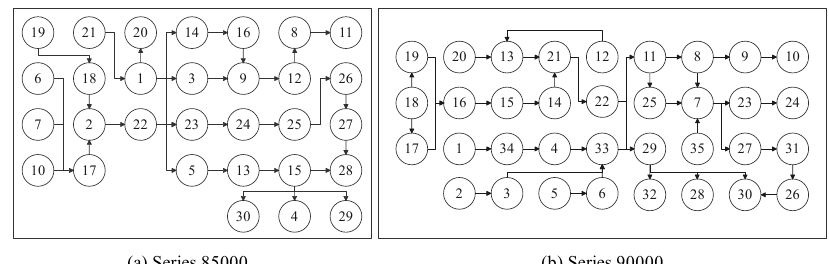
Figure 7. Precedence relationship of splitter